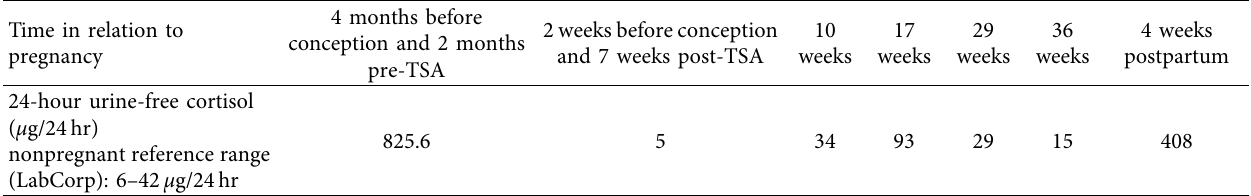
Table 1: 24-hour urine-free cortisol measurements collected approximately every 8 weeks throughout our patient’s pregnancy. Time in relation to